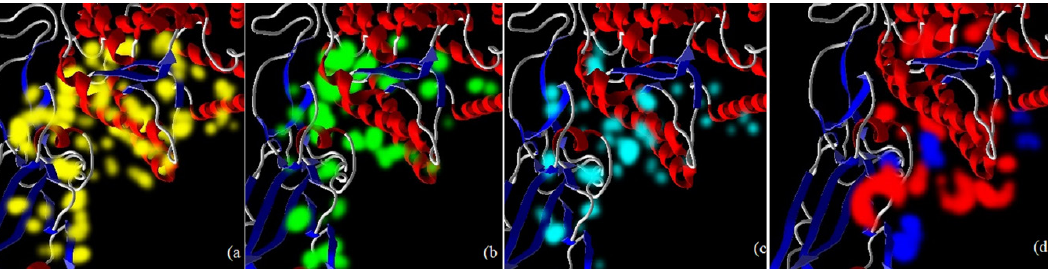
Fig. 1. Energy map of ACE2-RBD complex; a) hydrogen donor b) steric, c) hydrogen acceptor, and d) electrostatic.